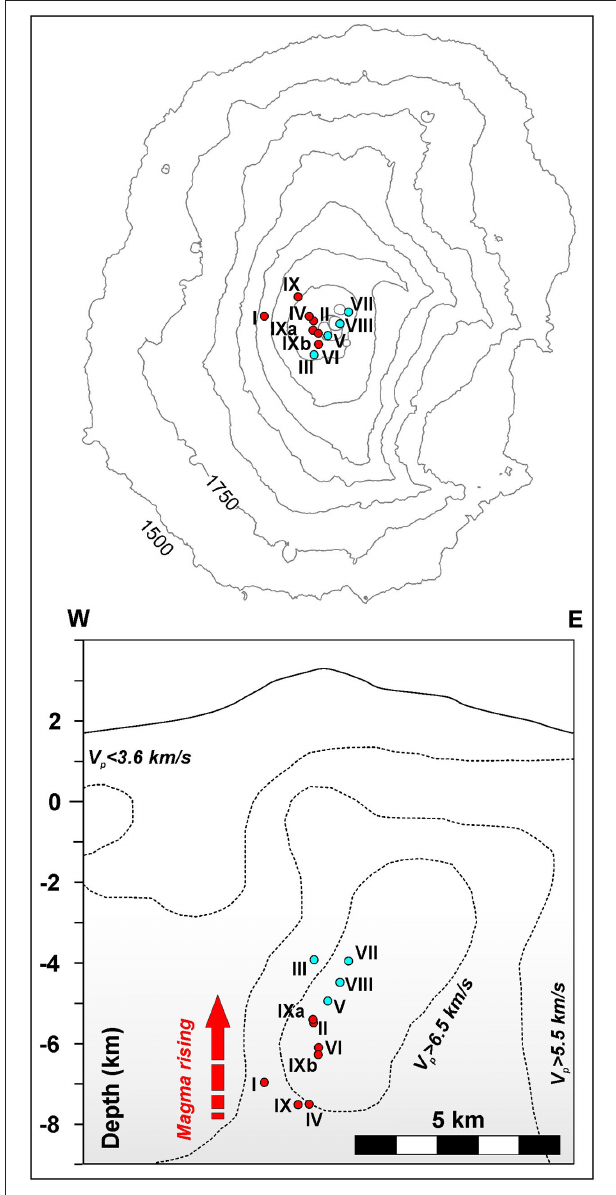
FIGURE 7 | The upper panel shows the areal location of pressure sources modeled for each phase (inflation in red and deflation in blue). The lower panel shows a cross-section highlighting the calculated depth of each phase. For comparison, the trace of the high vp body estimated by Aloisi et al. (2002) is also shown.